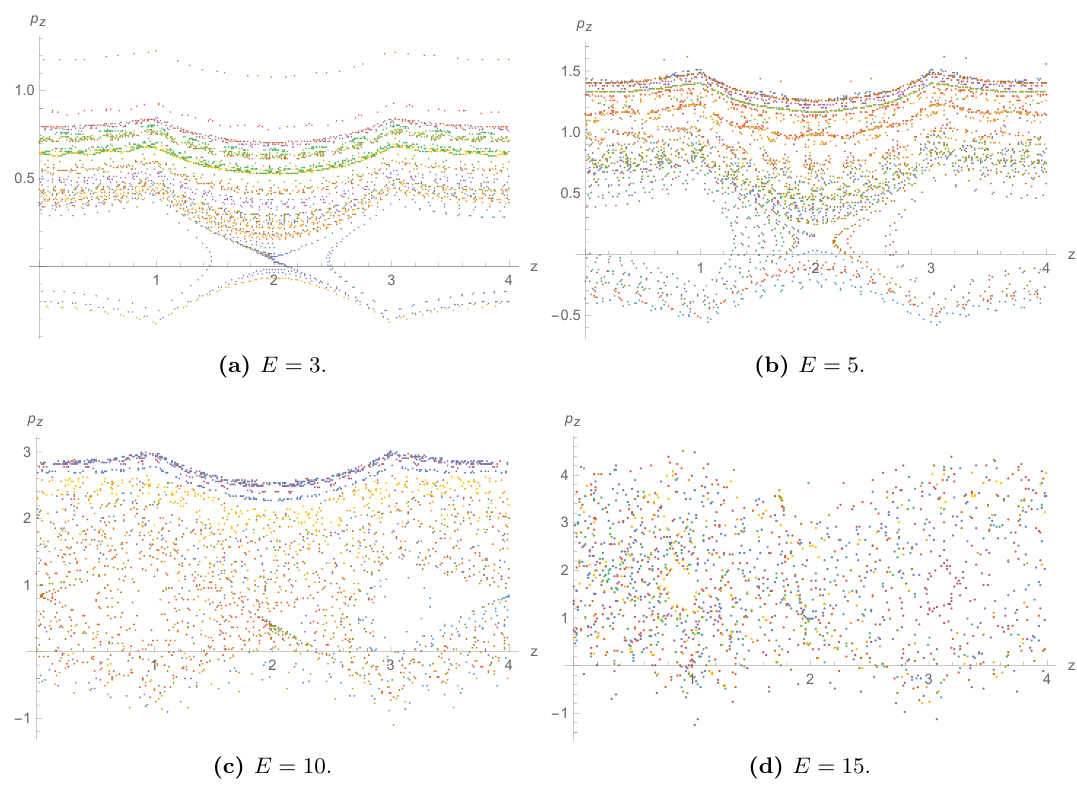
Figure 12. Poincar(cid:19)e sections for the ( z; p z )-plane at (cid:31) ( t ) = 0, for the quiver in eq. (2.7) at di(cid:11)erent